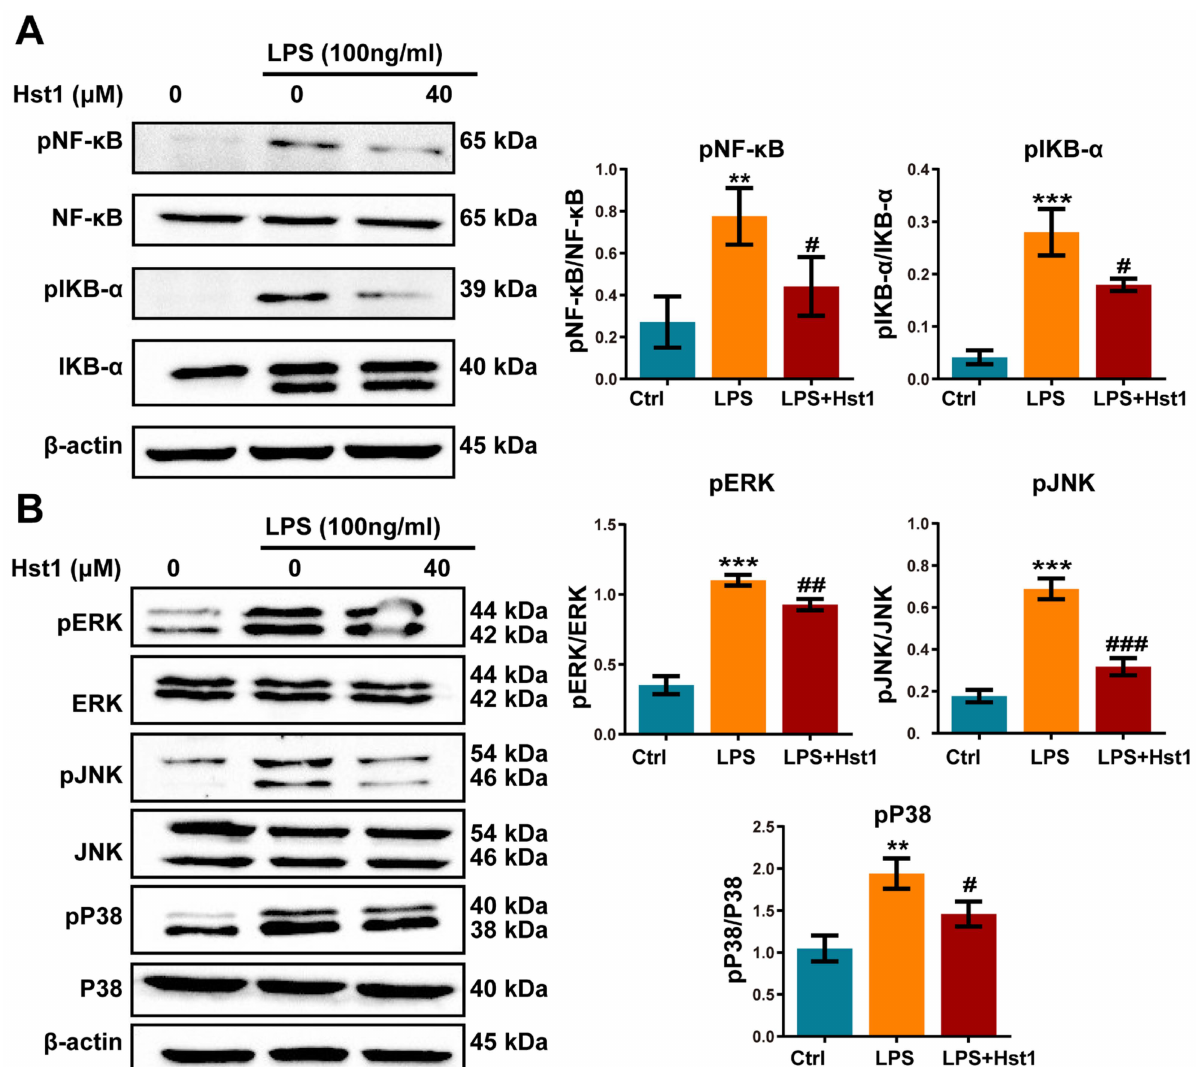
Figure 7. Hst1 treatment downregulated NF- κ B and MAPK signaling in LPS-treated macrophages. ( A , B ) Western blot analysis and qualification of NF- κ B signaling-related proteins MAPK signaling- related proteins pERK/ERK, pJNK/JNK, and pP38/P38. Blots are cropped from Supplementary File S2. Data are expressed as means ± SD from three independent experiments. Significant differences compared to the control group: ** p < 0.01 and *** p < 0.001, and compared to LPS group: # p < 0.05, ## p < 0.01, and ### p <